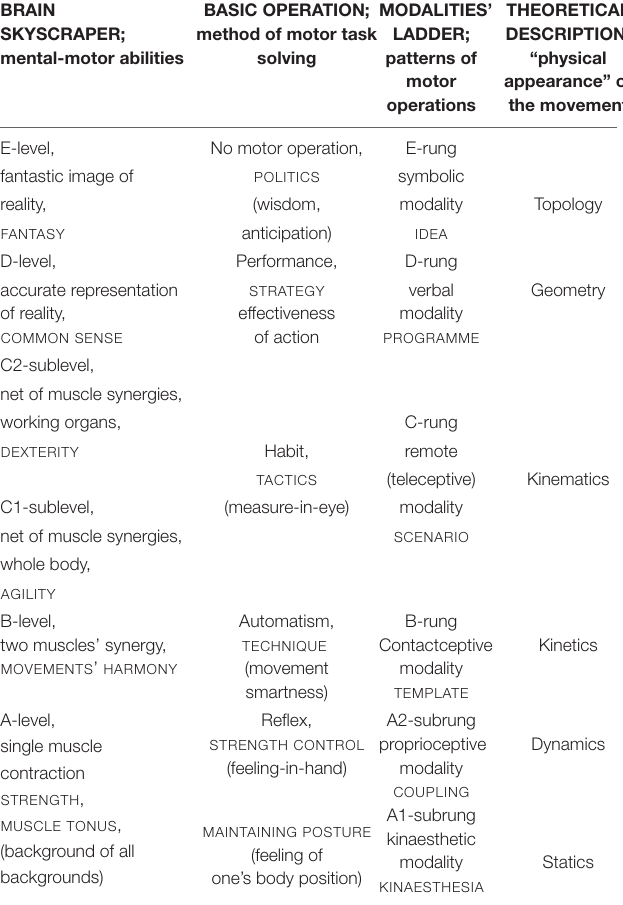
TABLE 2 | The comparison of the brain skyscraper and the modalities’ ladder (Petry´nski, 2016a, p. 103; Petry´nski, 2019, p. 48). BRAIN